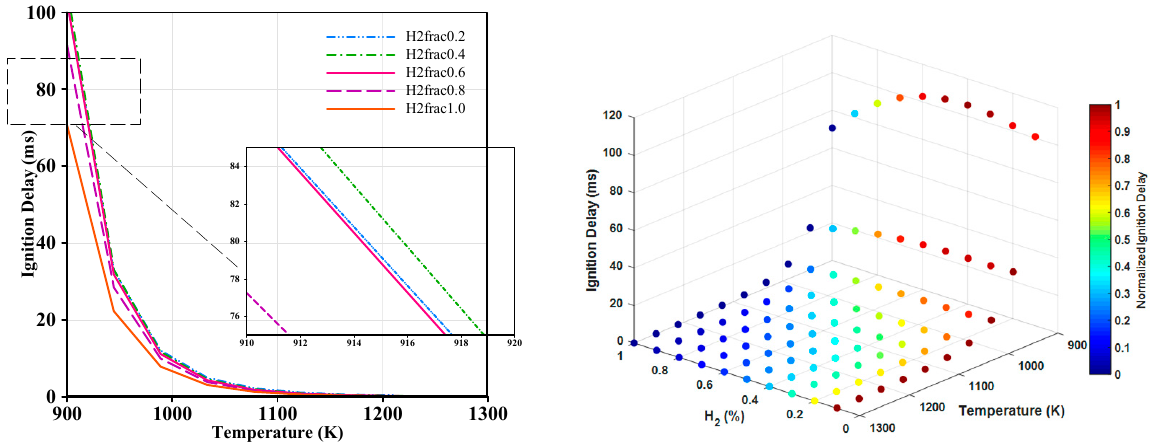
Figure 12. Effect of H 2 addition on methane’s ignition delay times at different temperatures at p = 40 bar (right image shows the normalized ignition delay time error for each case).